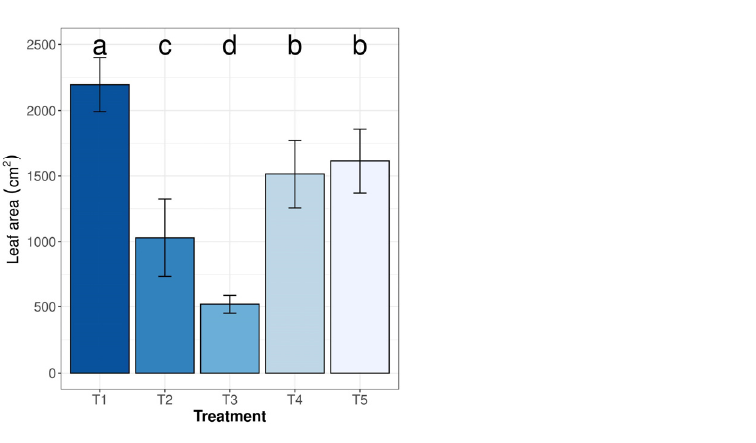
Figure 4. Boxplot of hazelnut Tonda Gentile plant height depending on substrate and DOY. T1 =